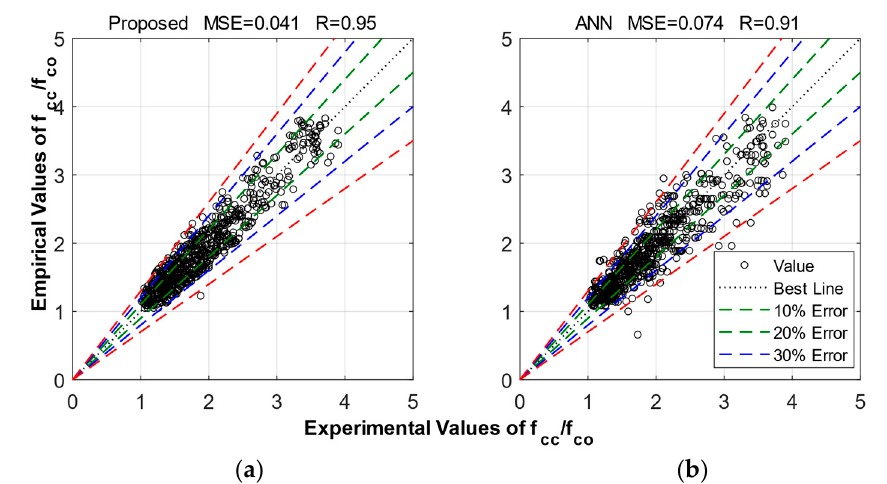
Figure 9. Performance for strength, for: ( a ) the proposed analytical model; ( b ) the corresponding ANN model.